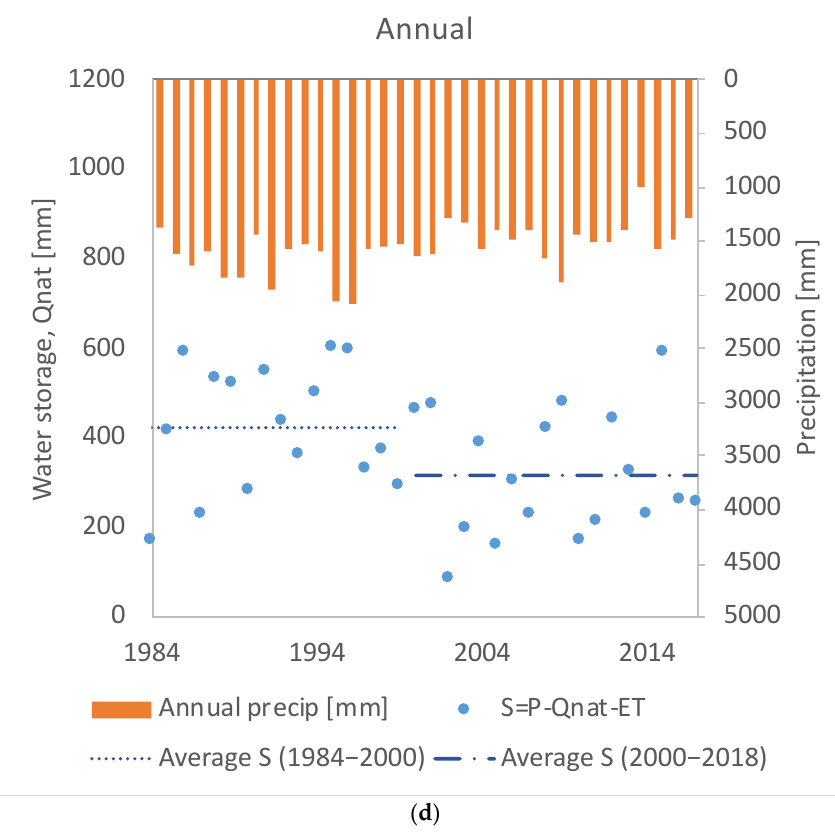
Figure A3. ( a ) Monthly evapotranspiration rates of different crops and tree species synthesized from multiple field observations and modeling studies; ( b ) water balance during wet season; ( c ) dry season; ( d ) annual water balance of the Jaguari – Jacarei watershed.